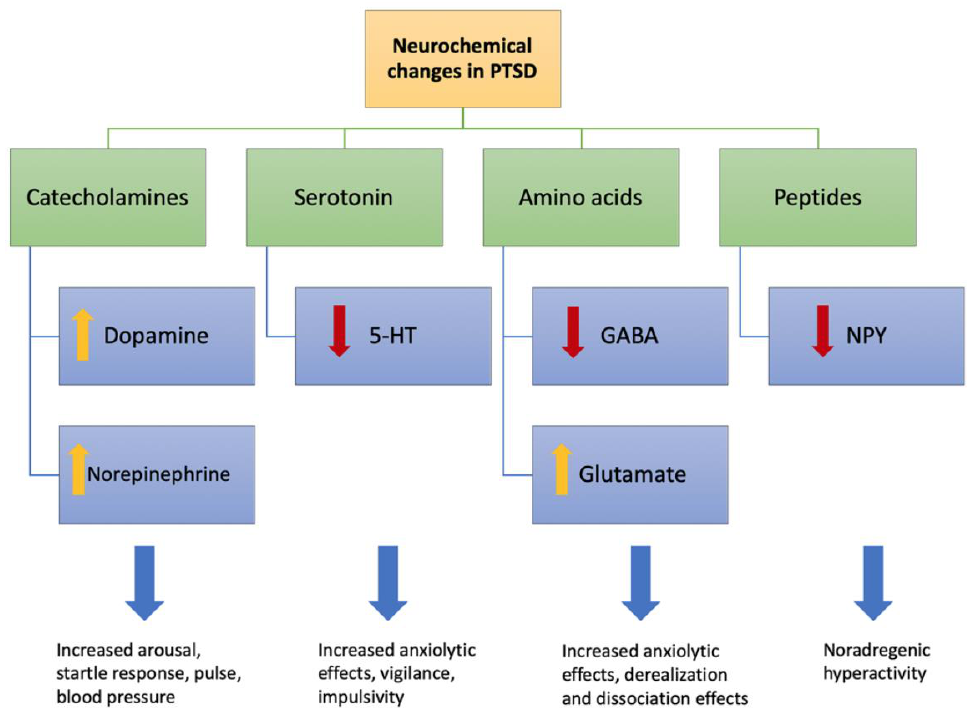
Figure 6. Neurochemical changes associated with PTSD. High levels of dopamine and norepinephrine have been observed in PTSD causing increased blood pressure, anticipation and astonishment response. A low level of serotonin (5HT) in PTSD increases anxiolytic e ff ects. GABA is an important inhibitory neurotransmitter and an alteration of the GABA receptor system results in a decreased level of GABA in PTSD. On the other hand, high levels of glutamate in PTSD can cause excitotoxic e ff ects leading to dissociation phenomena. Also, reduced levels of neuropeptide Y (NPY) in PTSD contributes to noradrenergic hyperactivity.